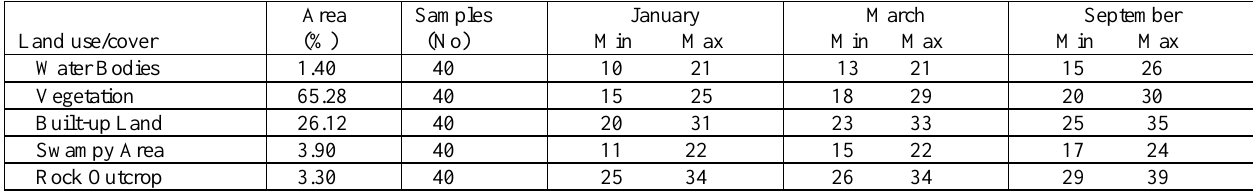
Table 6: Details of Land use/cover, number of temperature samples taken from land use/cover and season wise maximum and minimum average temperature ( O C).